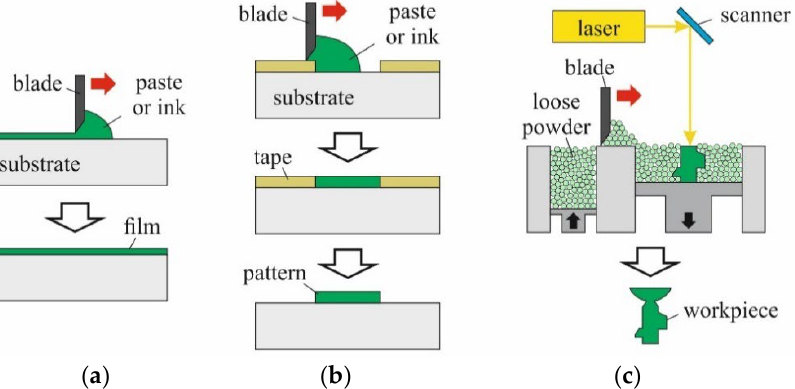
Figure 2. Schematic illustration of common applications of doctor blading: ( a ) thin film coating, ( b ) tape casting and ( c ) additive manufacturing of workpieces.